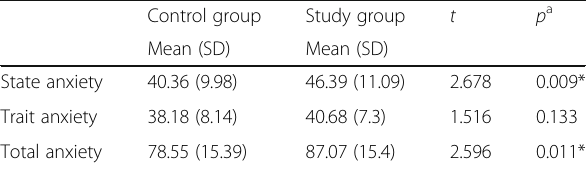
Table 2 Evaluation of anxiety scores between the groups Table 3 Evaluation of postoperative pain scores between